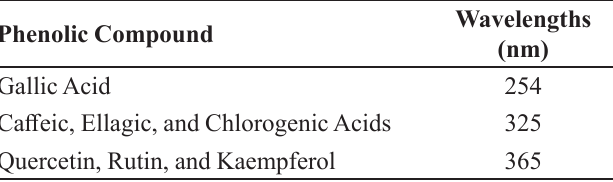
TABLE II - Wavelengths used for the detection of phenolic compounds by High-Performance Liquid Chromatography with Diode Array Detection